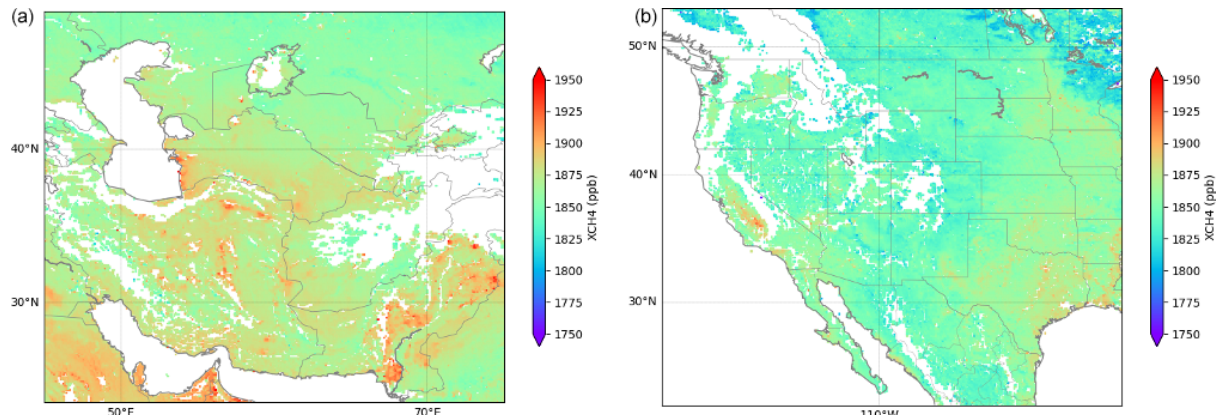
Figure 2. Regional zooms of TROPOMI XCH 4 columns for the full year 2019 in the Middle East (a) and central/western North America (b)